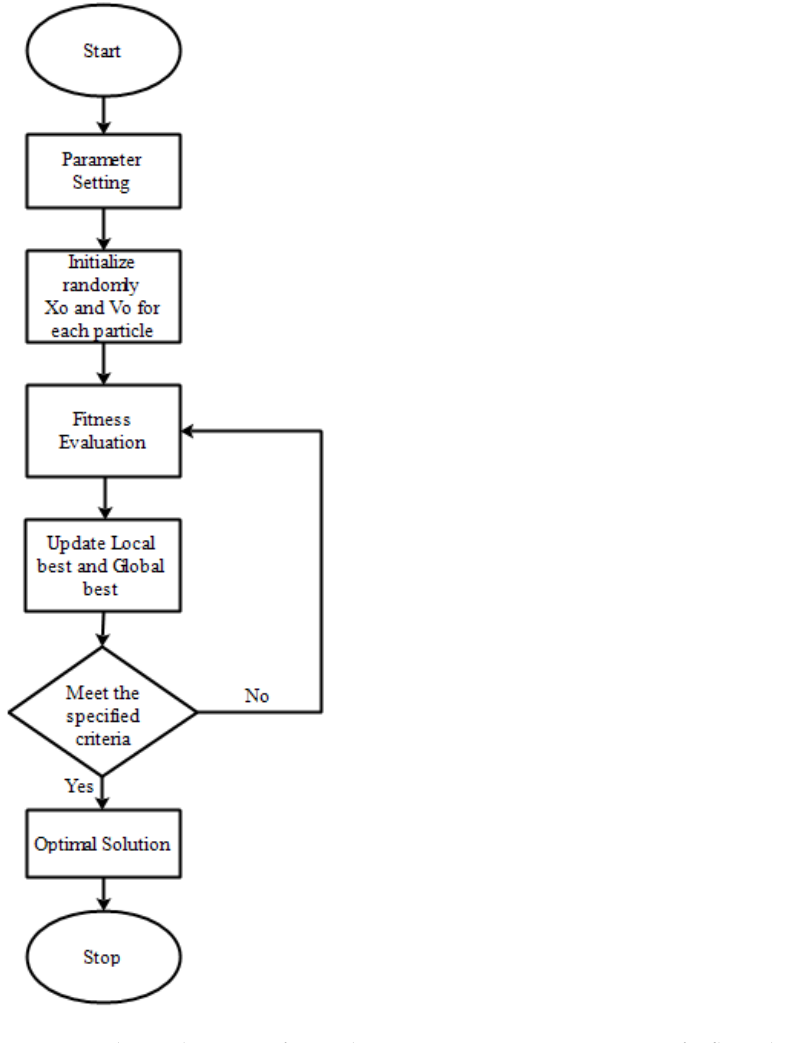
Figure 3. The explanation of particle swarm optimization in terms of a flow